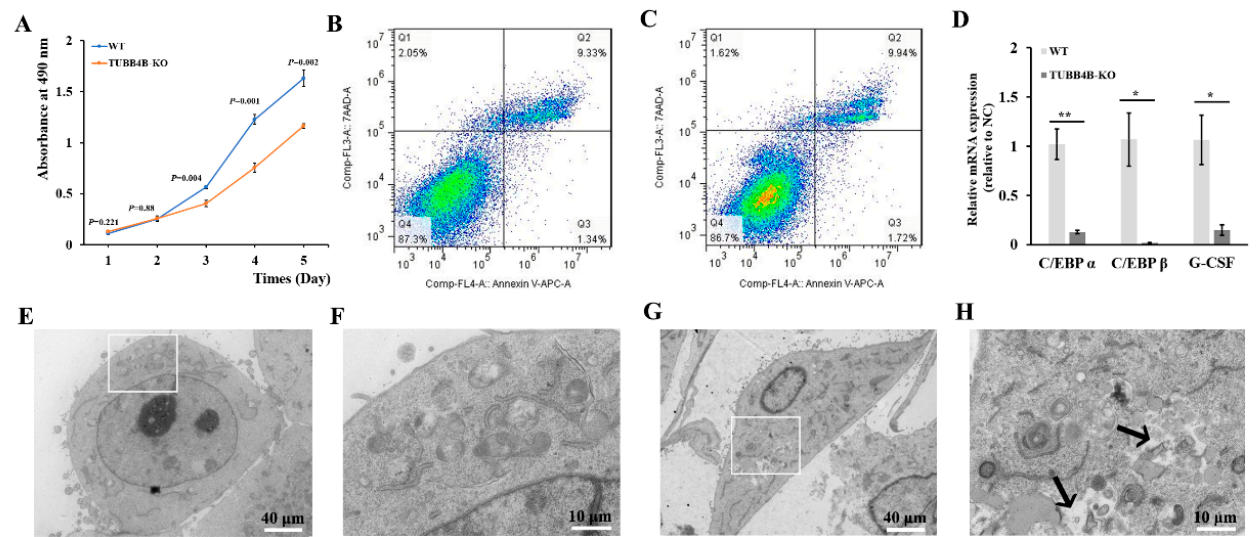
Figure 4. Loss of Tubb4b affects the proliferation of mouse spermatogonia. ( A ): Cell growth curve of control and TUBB4B-KO mouse spermatogonia. The p -values were obtained by t -test comparing with the TUBB4B-KO and control spermatogonia; ( B ): Apoptosis detection of control mouse spermatogonia; ( C ): Detection of apoptosis in spermatogonia of TUBB4B-KO mouse spermatogonia; ( D ): Gene expression of control and TUBB4B-KO mouse spermatogonia on cell proliferation. ‘*’ means 0.01 ≤ p -value < 0.05, while ‘**’ means 0.001 ≤ p -value < 0.01; ( E ): WT cell ultrastructural. The magnification was 1200 × , while the scale bar was 40 µ m. And the white rectangles indicate the region of ( F ); ( F ): Enlarged view of ( E ). The magnification was 5000 × , while the scale bar was 10 µ m; ( G ): Tubb4b -KO cell ultrastructural. The magnification and scale bar were the same as in ( E ), and the white rectangles indicate the region of ( H ); ( H ): Enlarged view of ( G ). The magnification and scale bar were the same as in Figure 4F.